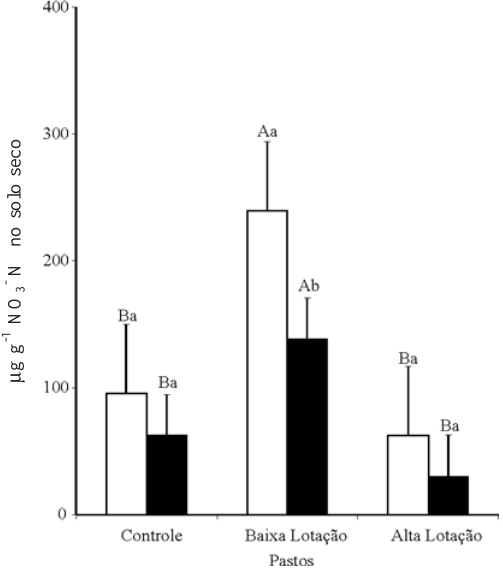
Figura 3. Atividade nitrificante encontrada nas camadas de 0–10 ( ) e 10–20 cm ( ) do solo pastejado por ovinos. Médias seguidas de mesma letra, minúscula (profundidade) e maiúscula (pastos), dentro de cada variável, não diferem entre si pelo teste de Tukey a 5 %. As barras representam o erro-padrão (n =